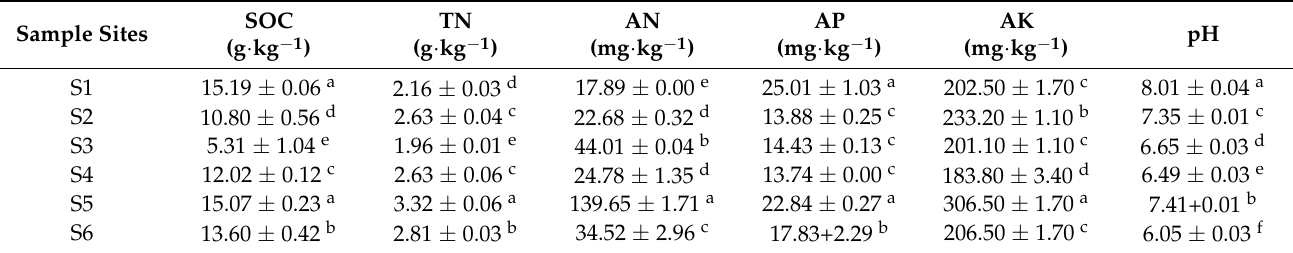
Table 2. Physicochemical properties of the soil at the sampling